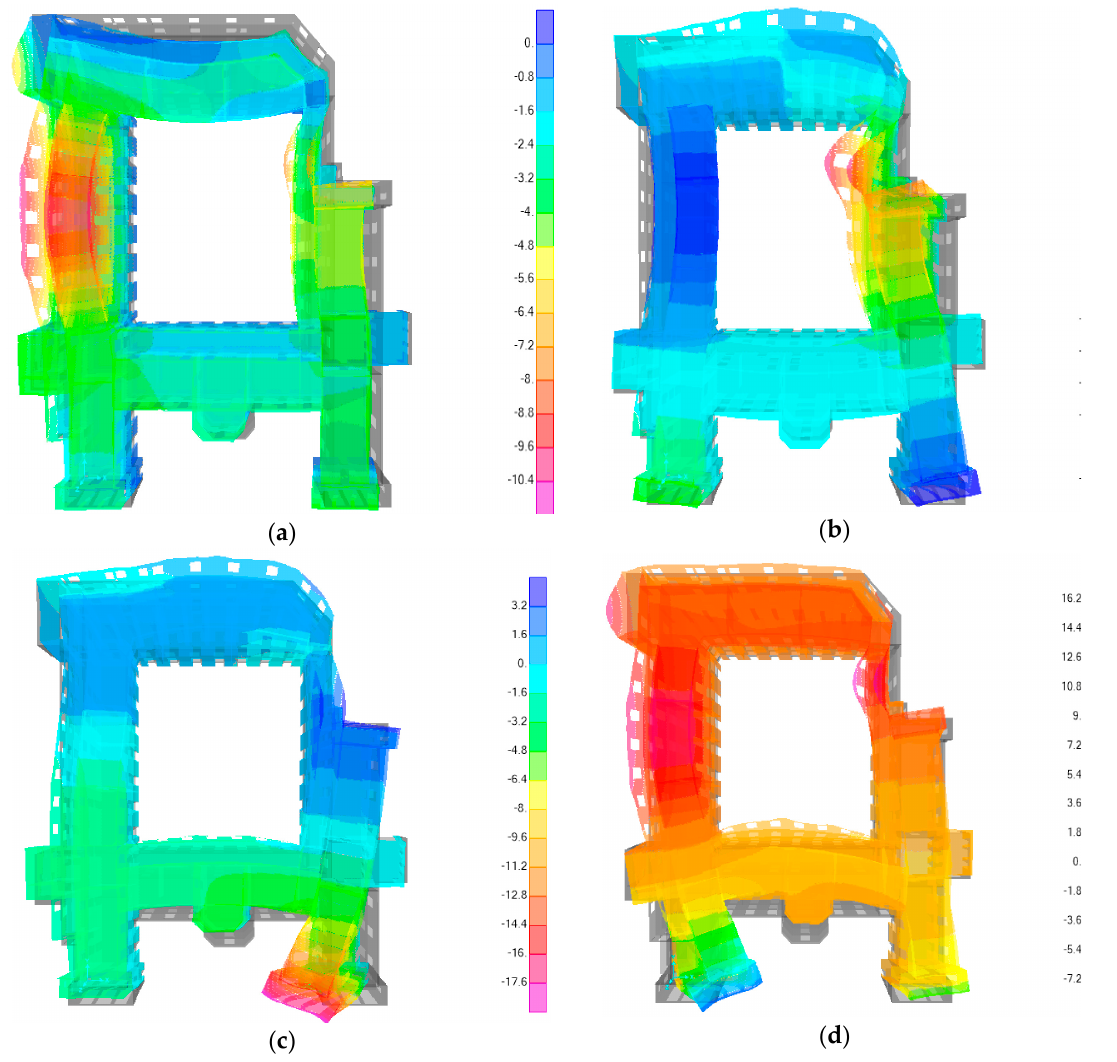
Figure 9. Deformed shape ( a ) mode 1 at the period of 0.295 sec, ( b ) mode 2 at the period of 0.292 sec, ( c ) mode 3 at the period of 0.276 sec, and ( d ) mode 4 at the period of 0.272 sec.